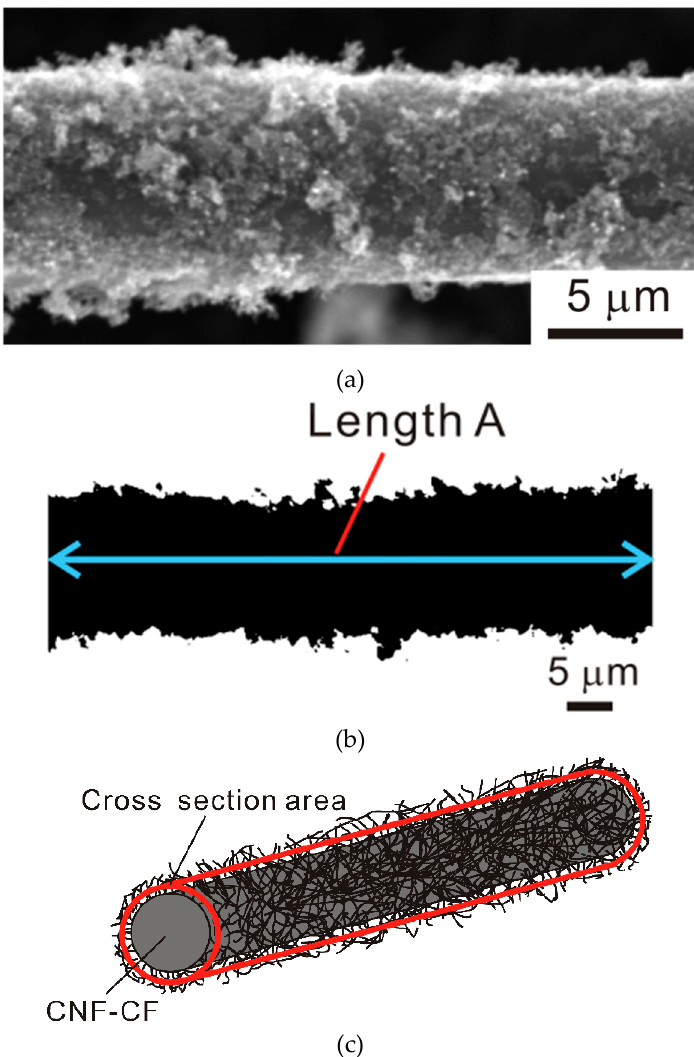
Figure 7. Schematic diagram for calculating the cross-section area of CNF-CF. ( a ) SEM image of CNF-CF. ( b ) Binary image of CNF-CF. ( c ) Schematic drawing of apparent cross section area of CNF-CF.